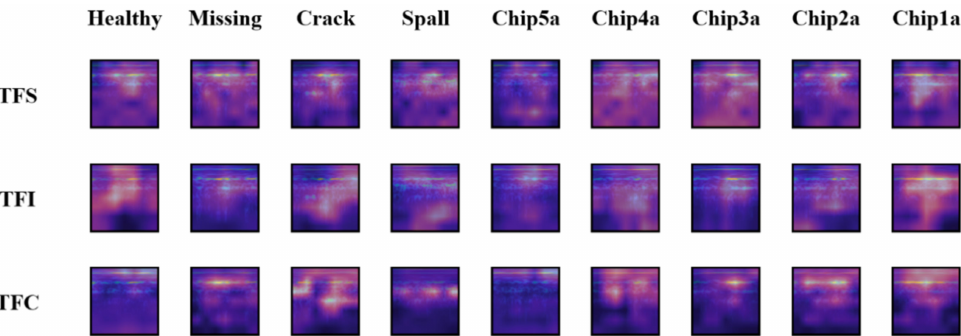
Figure 11. Heat maps and frequency spectrums of various states: ( a ) Healthy; ( b ) Spall; ( c ) Crack; ( d ) Chip.